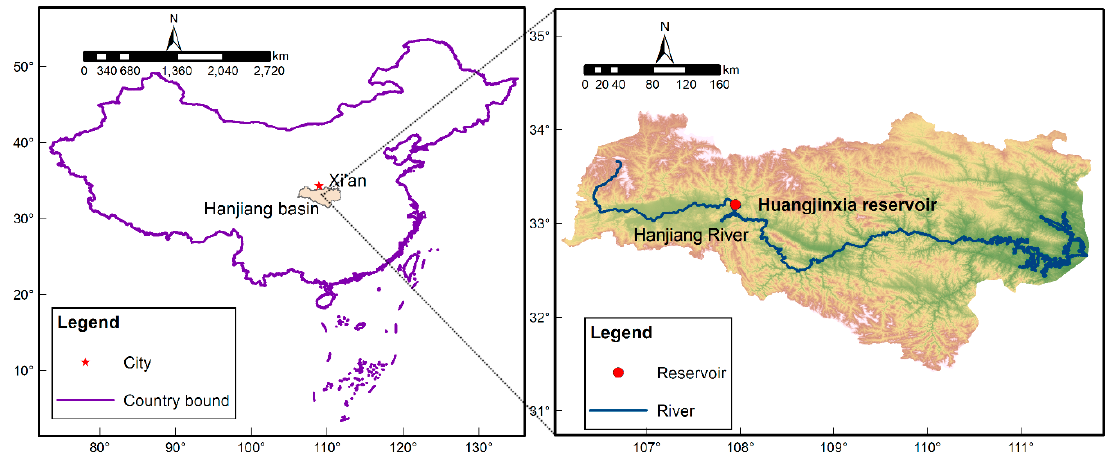
Figure 2. Location of the Huangjinxia reservoir.